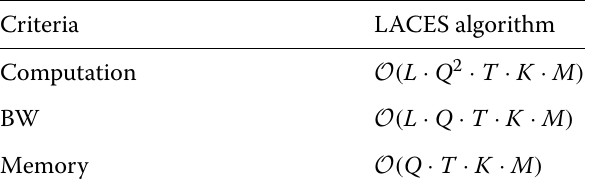
and calibration EM sequence algorithm Criteria LACES